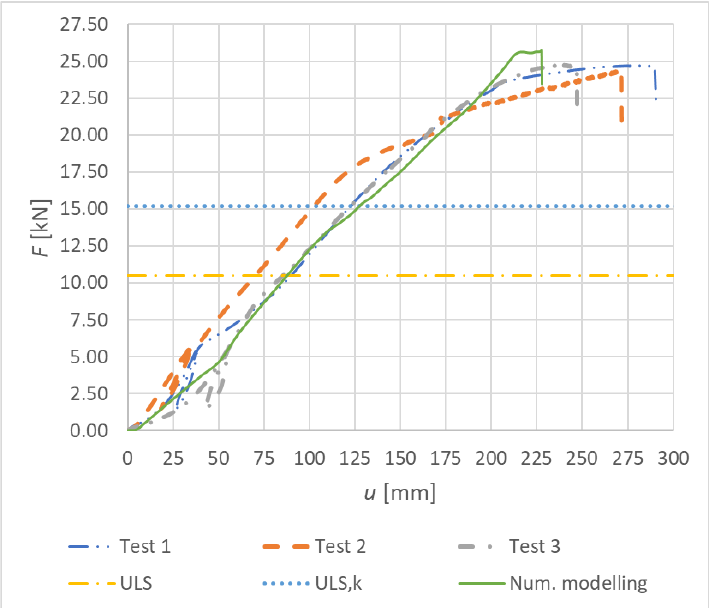
Figure 34. Load – deformation curves for Experiment B. Figure 34. Load–deformation curves for Experiment